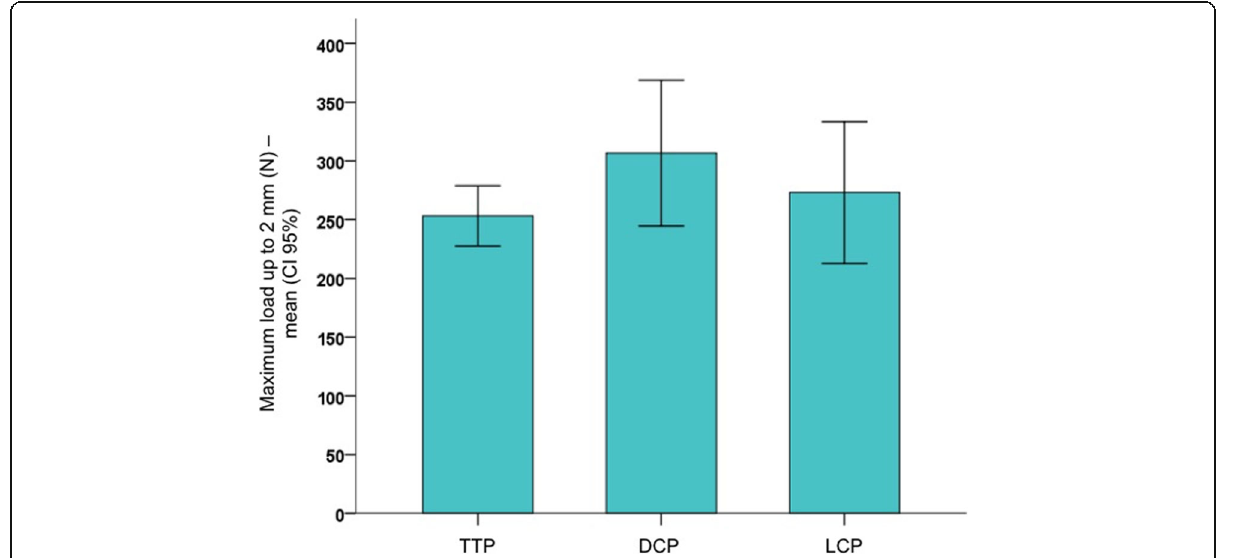
Fig. 5 Maximum load up to 2 mm (subsidence) for the three experimental groups (mean and CI 95%)